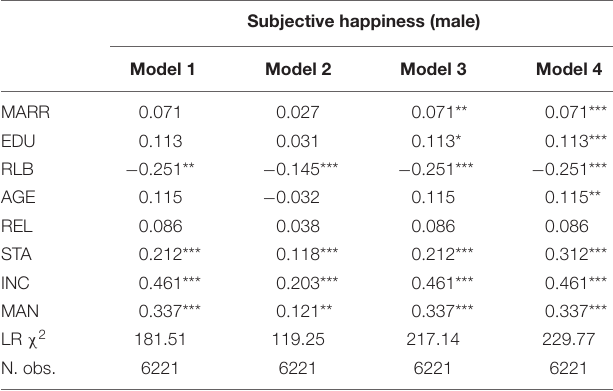
TABLE 5 | Determinants of subjective happiness (male